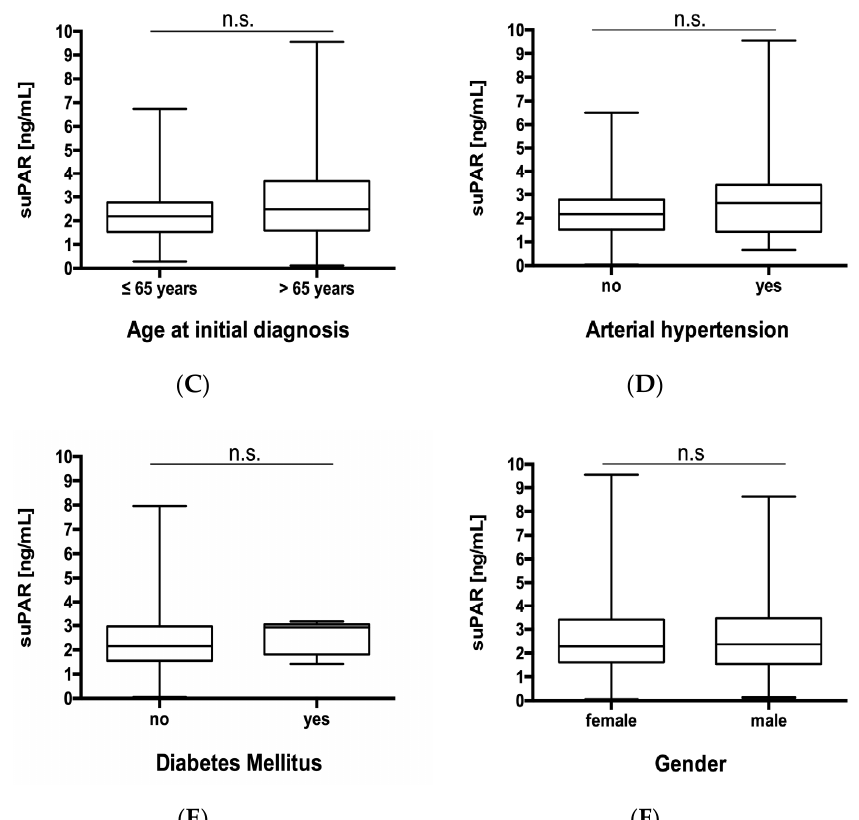
Figure 1. Serum suPAR levels are elevated in NET patients. ( A ) Serum concentrations of suPAR are significantly elevated in patients with NET compared to healthy controls. ( B ) suPAR levels display an AUC value of 0.7456 regarding the discrimination of NET patients and healthy controls. SuPAR levels were similar in patients ( C ) with or without arterial hypertension ( D ) with or without type 2 diabetes and ( E ) patients younger / older than 65 years and ( F ) did not vary with respect to patients’ gender. Box plot are displayed, where the bold line indicates the median per group, the box represents 50% of the values. The horizontal lines show minimum and maximum values of calculated nonoutlier values (**** p < 0.0001). NET, neuroendocrine tumors; suPAR, soluble urokinase-type plasminogen activator receptor; AUC, area under the curve.